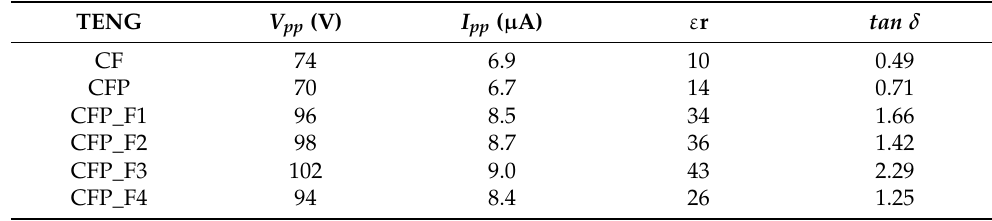
Table 3. Electrical output voltage ( V pp ) and current ( I pp ) of CF, CFP_F1–F4 TENGs.